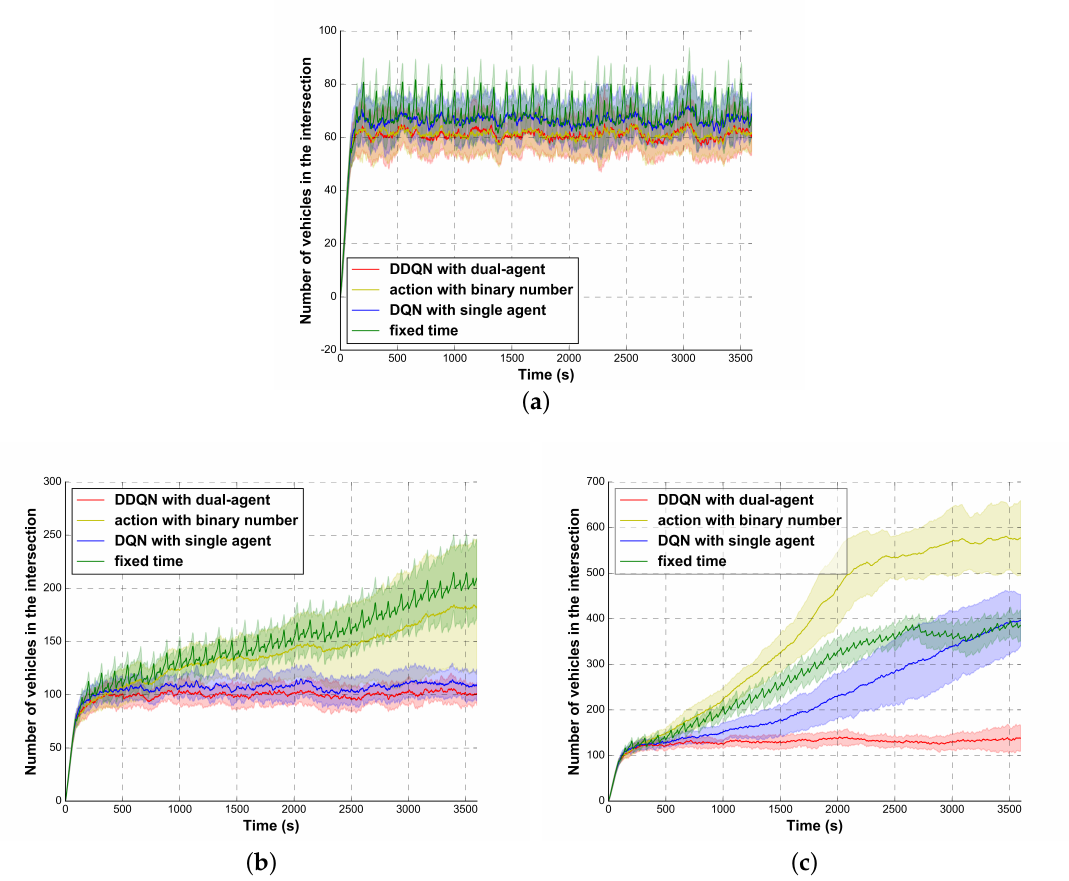
Figure 10. The number of vehicles existing in the intersection per second: ( a ) vehicle production 2520 veh/h; ( b ) vehicle production 3600 veh/h; ( c ) vehicle production 4320